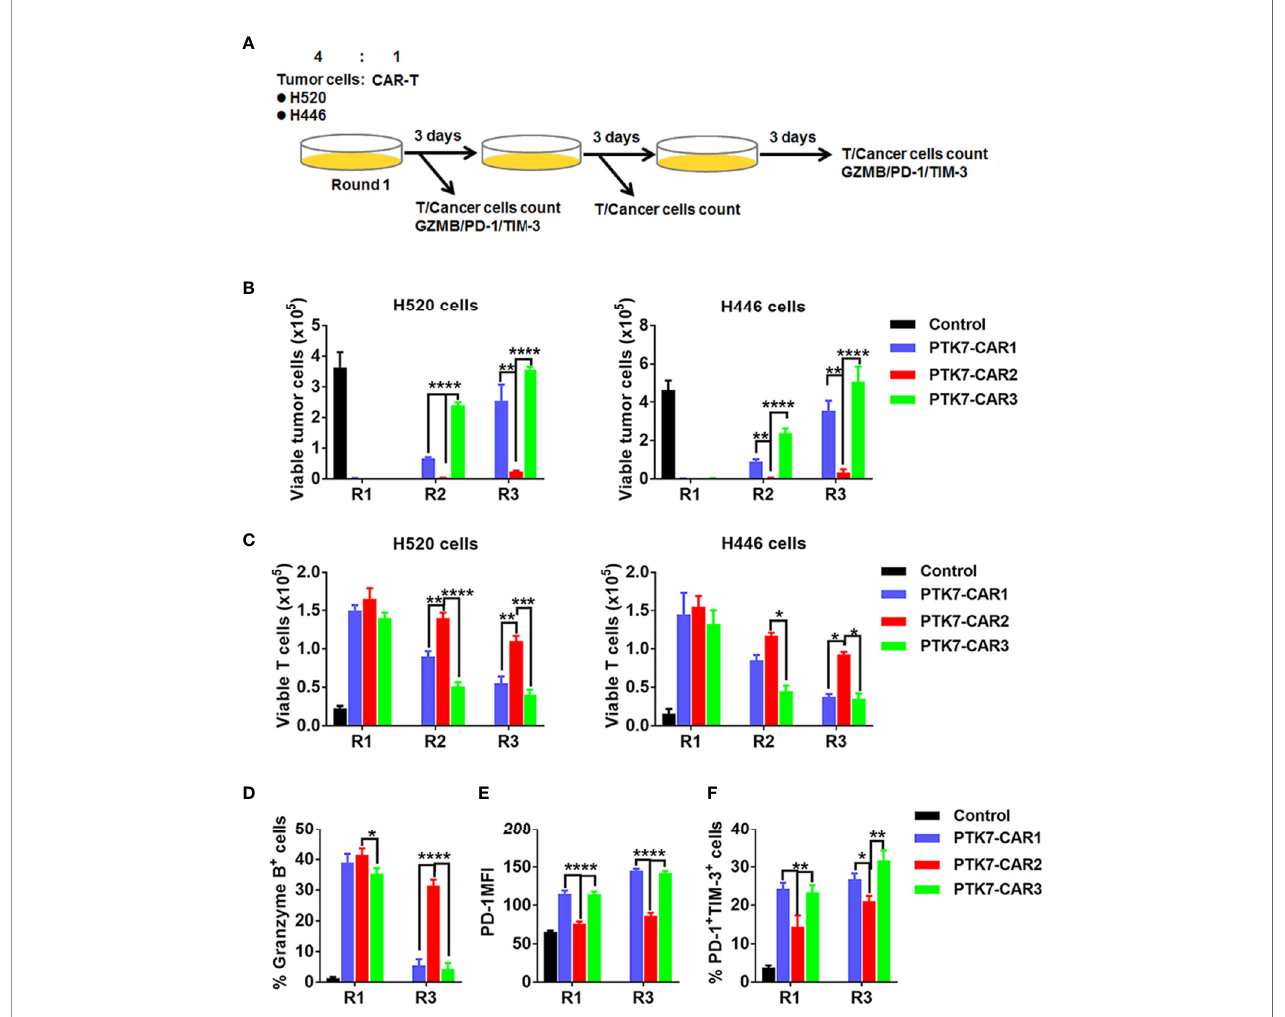
FIGURE 5 | PTK7-CAR2 T cells retain effector function upon recursive target exposure. (A) Schematics of the long-term cytotoxicity assay. (B) Counts of H520 and H446 target cells after each round of recursive co-culture (rounds 1 – 3, R1 – R3) with control or PTK7-CAR T cells. (C) Counts of control or PTK7-CAR T cells after each round of recursive co-culture with target cells. (D) Intracellular staining for granzyme B of control or PTK7-CAR T cells at the end of round 1 and 3 co-culture with H520 tumor cells. (E) PD-1 expression in control or PTK7-CAR T cells after rounds 1 and 3 of recursive co-culture with H520 tumor cells. (F) Percentage of PD- 1 + TIM-3 + cells in control or PTK7-CAR T cells after rounds 1 and 3 of recursive co-culture with H520 tumor cells. Data are shown as mean ± SEM (n = 3). *P < 0.05, **P < 0.01, ***P < 0.001, and ****P < 0.0001, determined by repeated-measures two-way ANOVA with Tukey ’ s post hoc